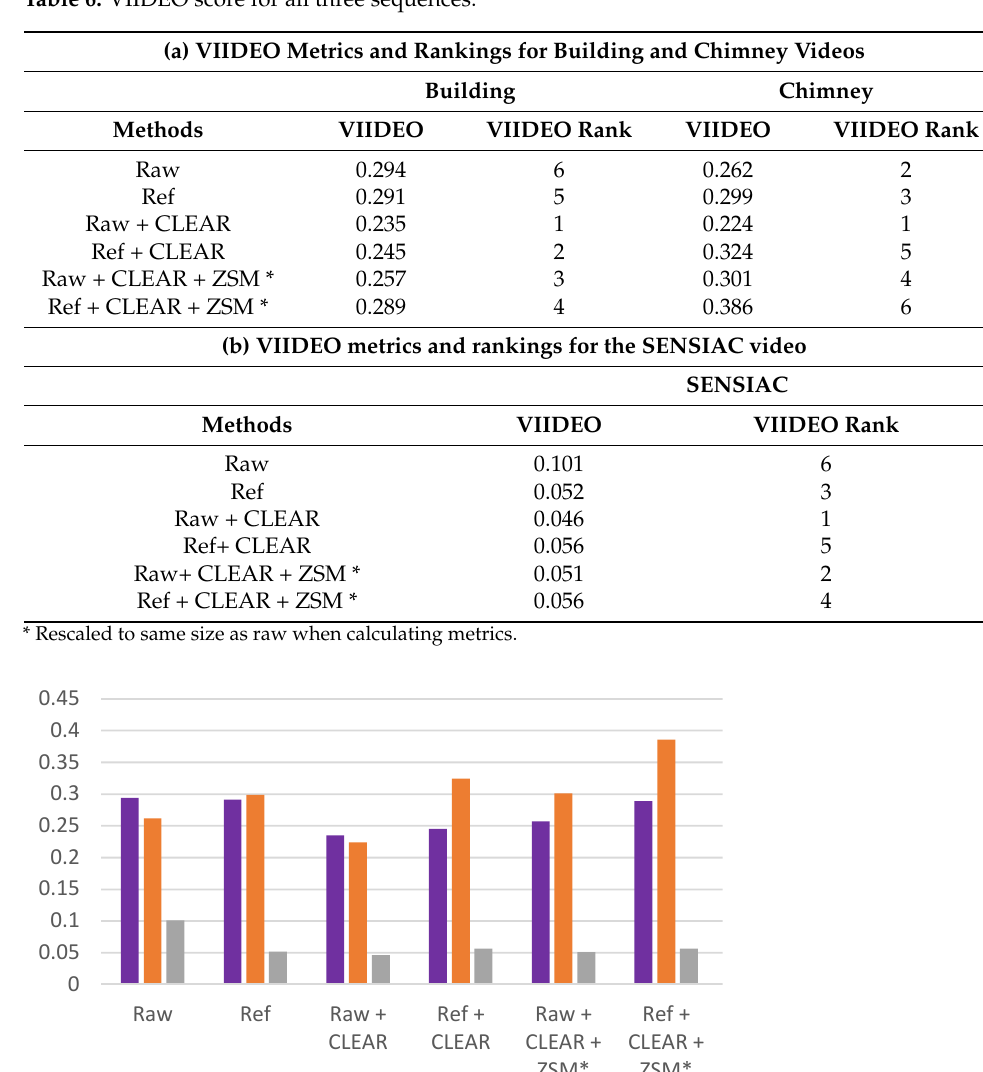
SENSIAC Methods